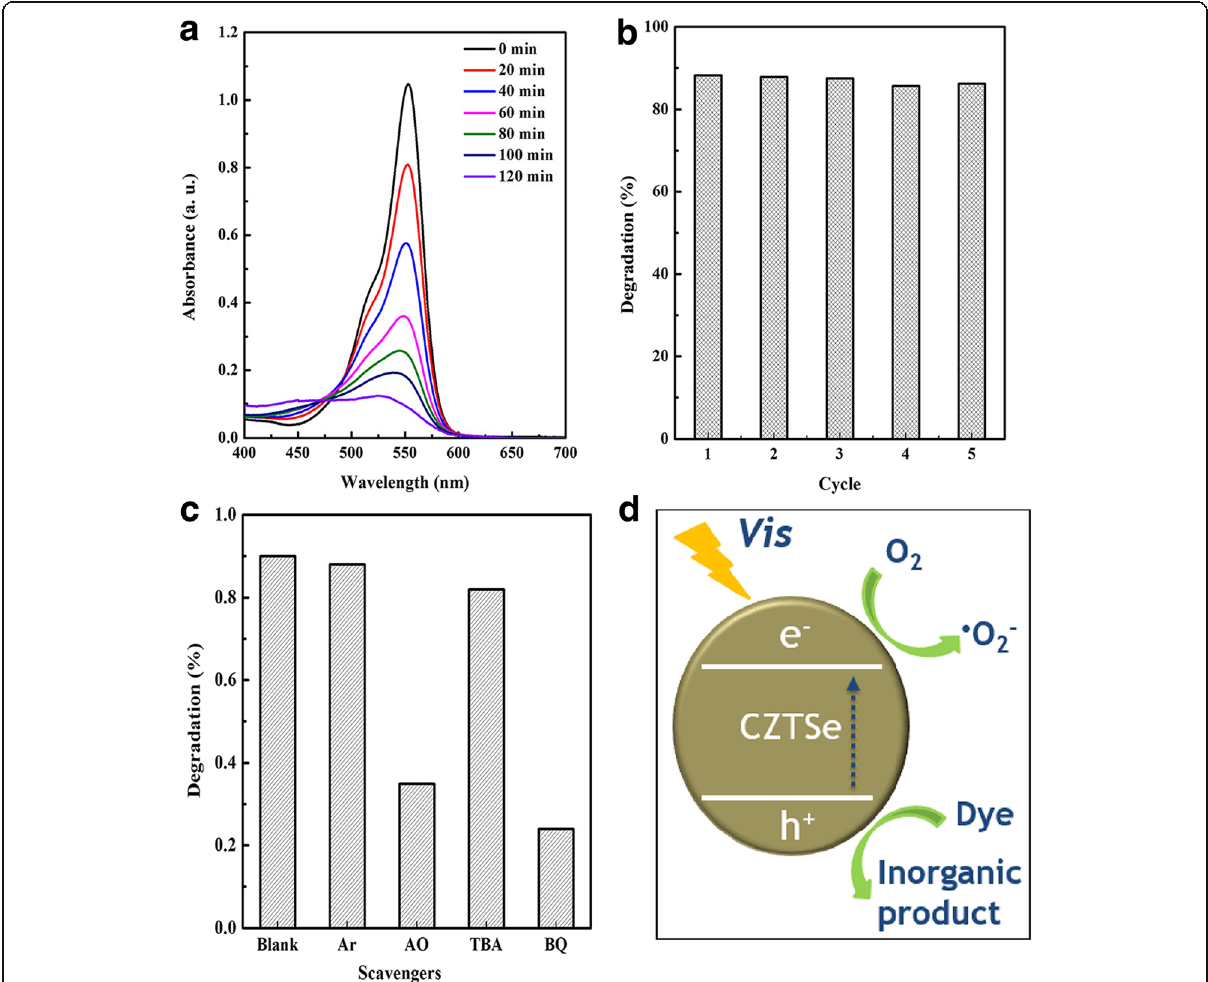
Fig. 4 a RhB degradation. b Cycle test. c Effects of various quenchers on the degradation efficiency of RhB. d Scheme of the photocatalytic degradation